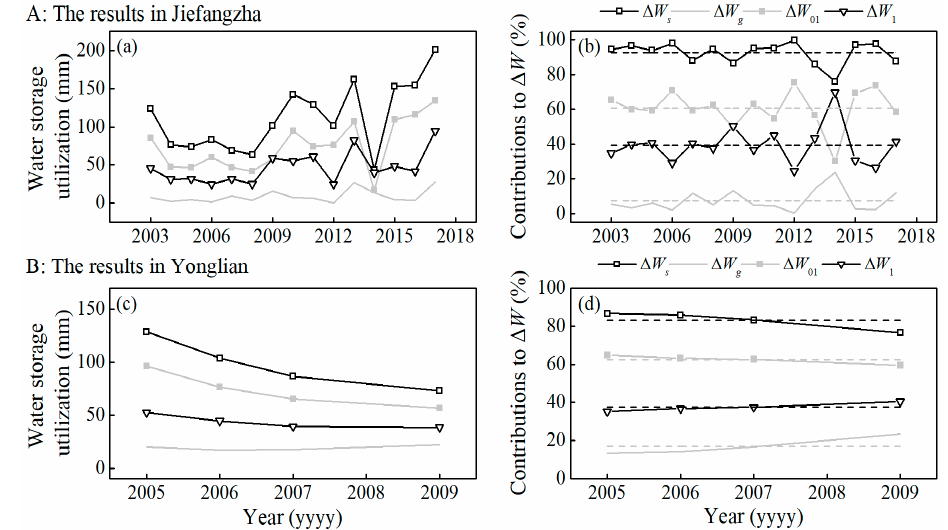
Figure 7. The results of soil water storage utilization ( ∆ W s ), ground water utilization ( ∆ W g ), soil-ground water storage utilization below 1 m soil depth ( ∆ W 1 ), soil-ground water storage utilization above 1 m soil depth ( ∆ W 01 ) and their contributions to the soil-ground water storage utilization ( ∆ W ) in Jiefangzha and Yonglian. ( a ) and ( c ) The results of these water storage utilizations in Jiefangzha and Yonglian, respectively. ( b ) and ( d ) The results of the contributions of water storage utilizations to soil-ground water storage utilization ( ∆ W ) in Jiefangzha and Yonglian, Table 4. Statistical results of Δ W s , Δ W g , Δ W 01 , Δ W 1 , η g , η 1 and η in Jiefangzha and Yonglian.